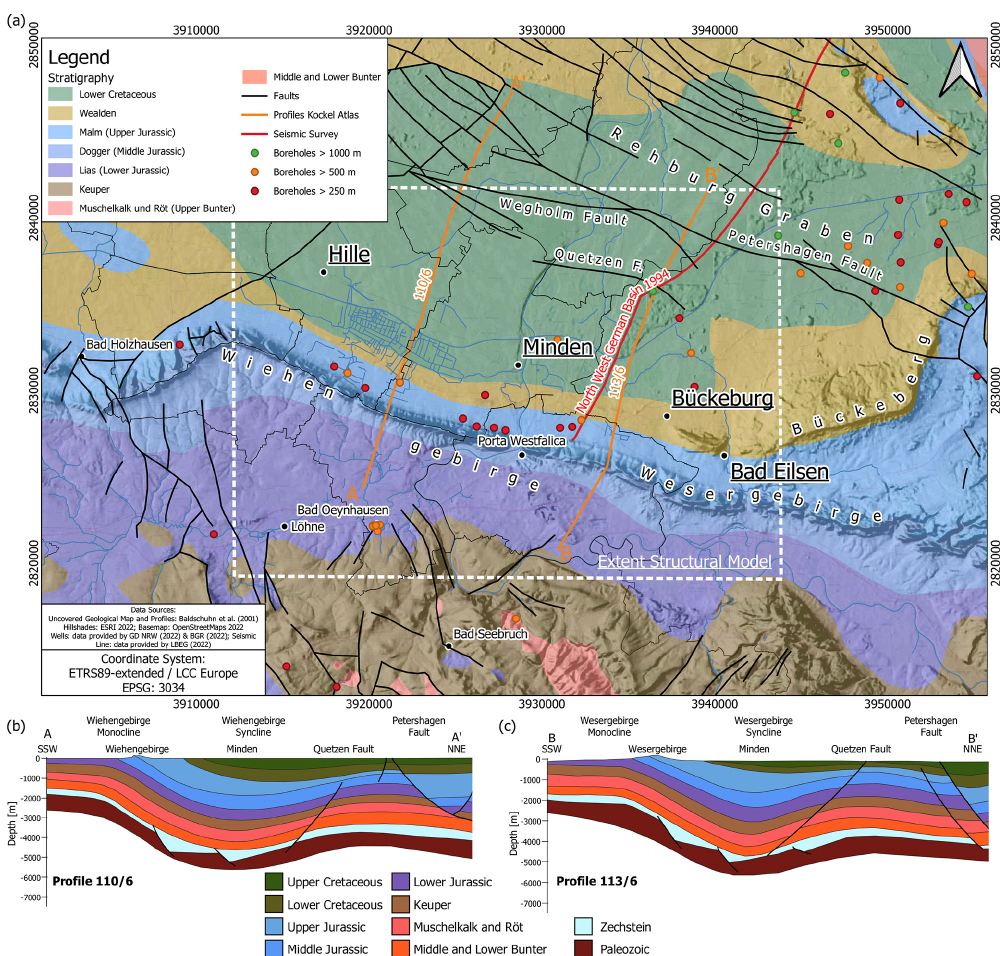
Figure 2. (a) Uncovered geological map of the area of Minden zoomed in from Fig. 1 (Baldschuhn et al., 2001). The locations of the cross- section in (b) and (c) and the integrated seismic section (RHBGOSTO U940999) are indicated. Wells with a depth greater than 250m are shown. (b) & (c) Profiles 110/6 and 113/6 across the Wiehengebirge and Wesergebirge Monocline and Syncline (Baldschuhn et al.,